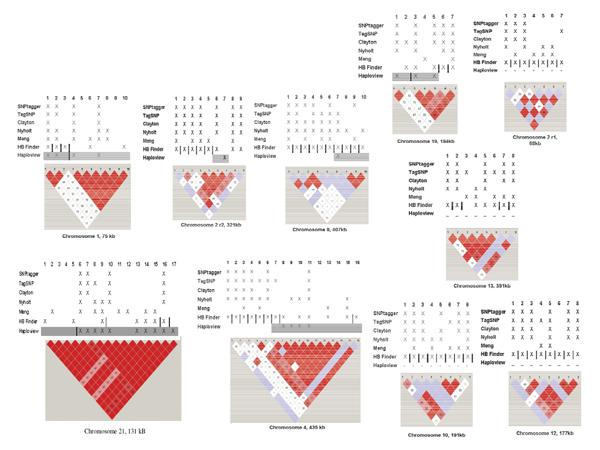
Selected SNPs and linkage disequilibrium plots. Figure 1 depicts the LD (D') and the tag SNPs selected by each program. Red regions depict D' = 1.0 with strong confidence. Light blue regions are D' = 1.0 but decreased confidence. White regions are D' < 1 and state D' within the box. An X denotes that SNP was selected by the program. The gray shading in the HAPLOVIEW row represents the Gabriel blocks. The dark lines represent breaks between blocks for both HAPLOVIEW and HaploBlock Finder. For some chromosomes no blocks were identified and this is indicated by hatch marks across the SNPs.